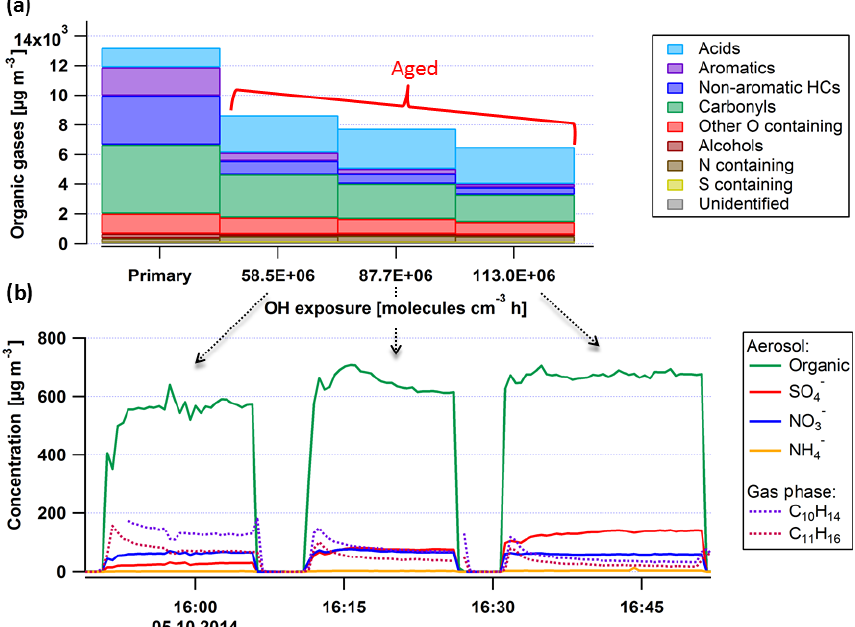
Figure 2. Sample experiment showing mean NMOG emissions (a) and representative time series for particle and NMOG components (b) for varying OH exposures. Hydrocarbon concentrations (nonaromatic HCs (dark blue), aromatic HCs (purple), and carbonyls (green)) decrease in the PAM while the concentrations of acids (mostly formic and comprising ∼ 90% of the total acids) increase. Panel (b) shows the aerosol (Organic, SO 4 , NO 3 , NH 4 ) formed and gaseous aromatics (C 10 H 14 , C 11 H 16 ) for the different OH exposures in the PAM given in (a) .